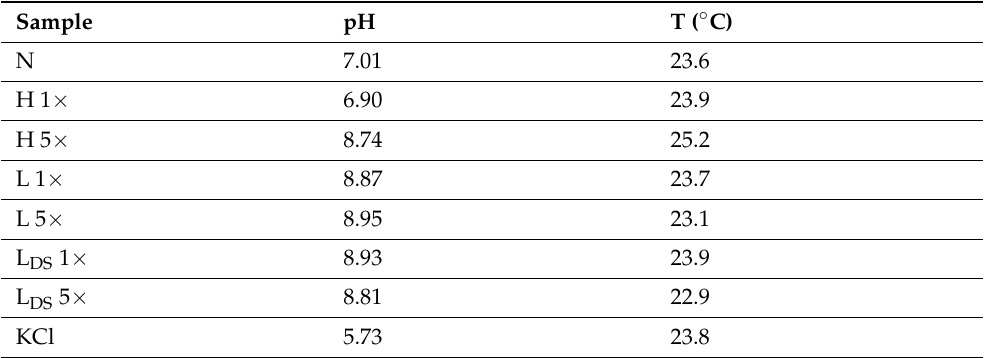
Table 8. pH of the aqueous extract of the whole mask samples before and after washing.